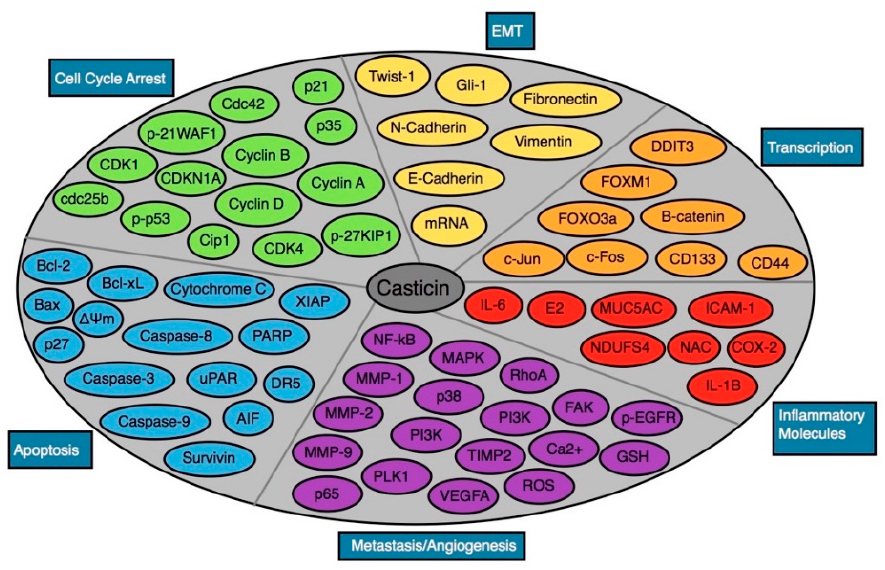
Figure 3. Di ff erent proteins modulated by Figure 3. Different proteins modulated by casticin.